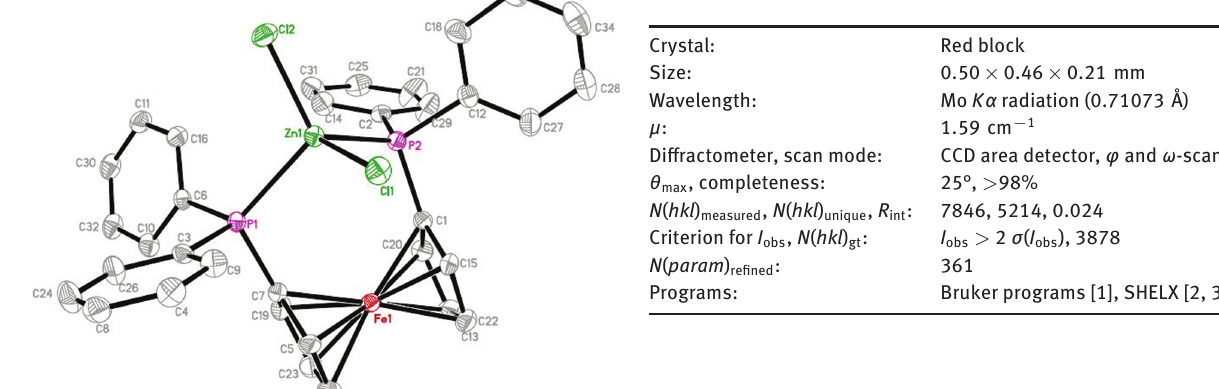
Table 1: Data collection and